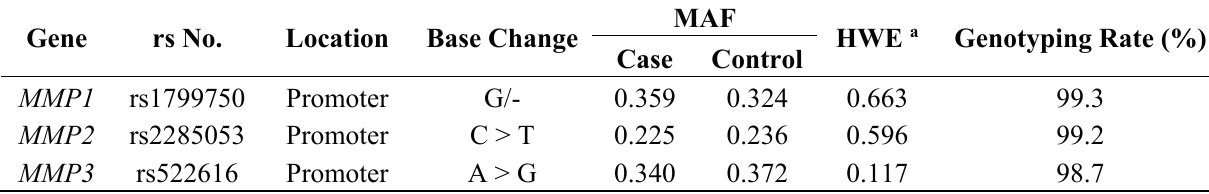
Table 2. Primary information of genotyped